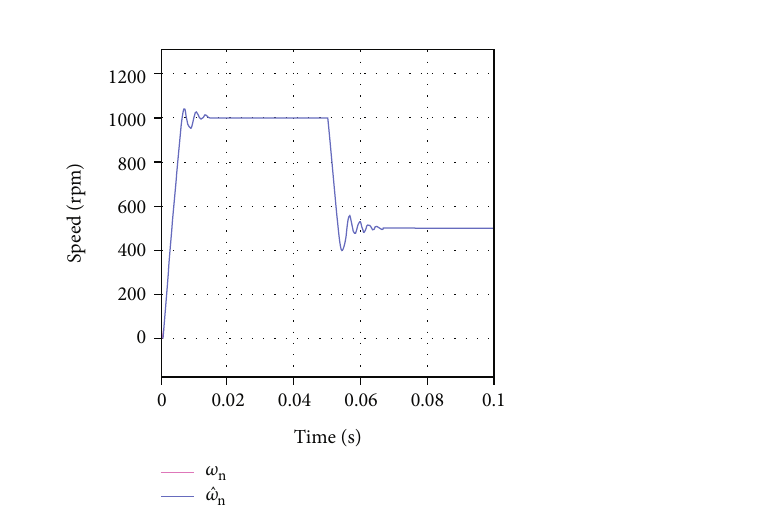
Figure 27: Estimated speed and actual speed for proposed method at Case 2.